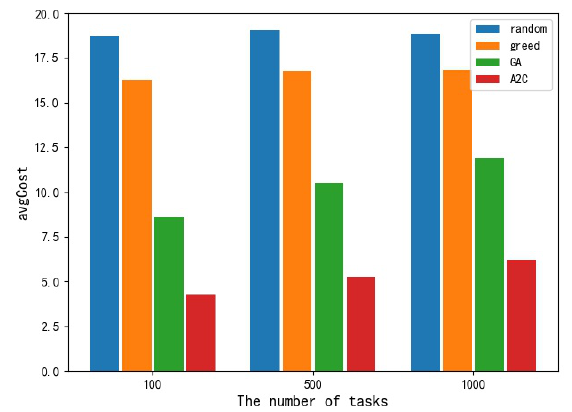
Figure 6. Comparison of different algorithms in